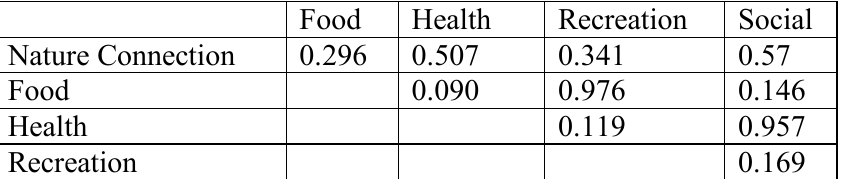
Table A3.4. GLMM model results for pairwise comparisons examining differences in crop plant richness based on motivations of gardeners. Numbers show p-values for pairwise comparisons of different levels for reach factor.